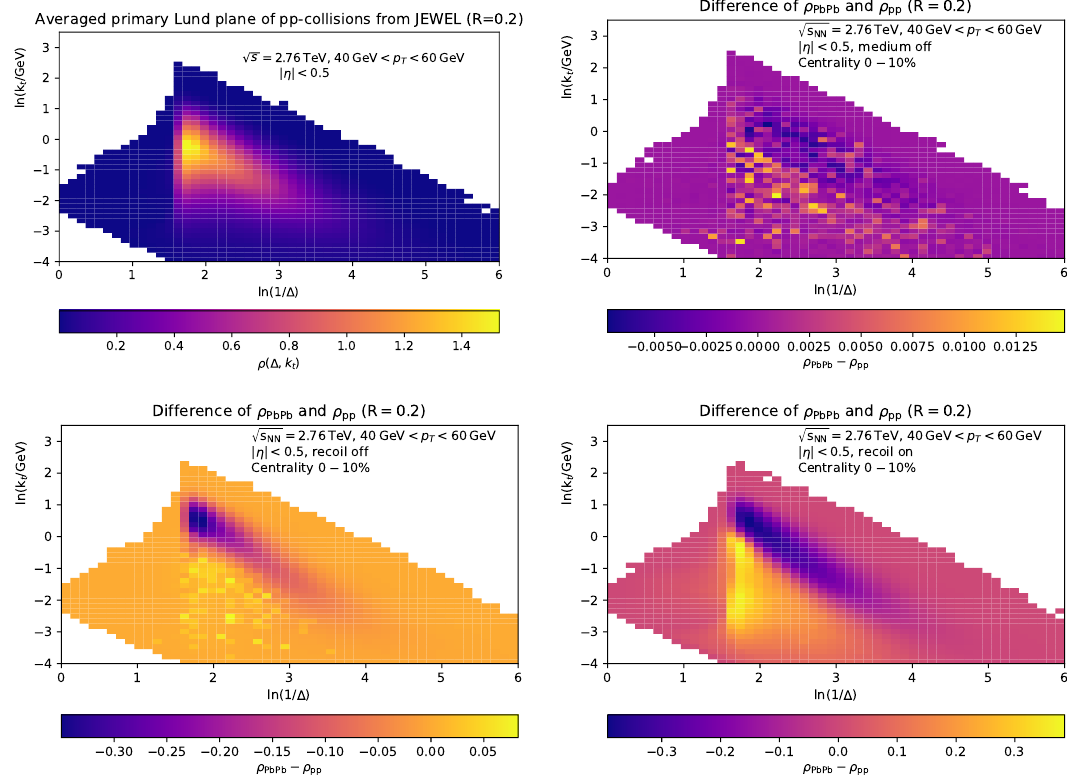
Figure 11 . The average primary Lund plane density ρ for jets simulated with JEWEL, initially clustered with the anti- k algorithm ( R = 0 . 2 , 40 < ˆ p 60 GeV and | η | < 0 . 5 ) and then reclustered T T < with the Cambridge/Aachen algorithm. (a) pp collisions, (b) the difference of pp and central PbPb collisions with the medium turned off, (c) the same with the medium turned on and recoil turned off, and (d) the same with both the medium and the recoil turned